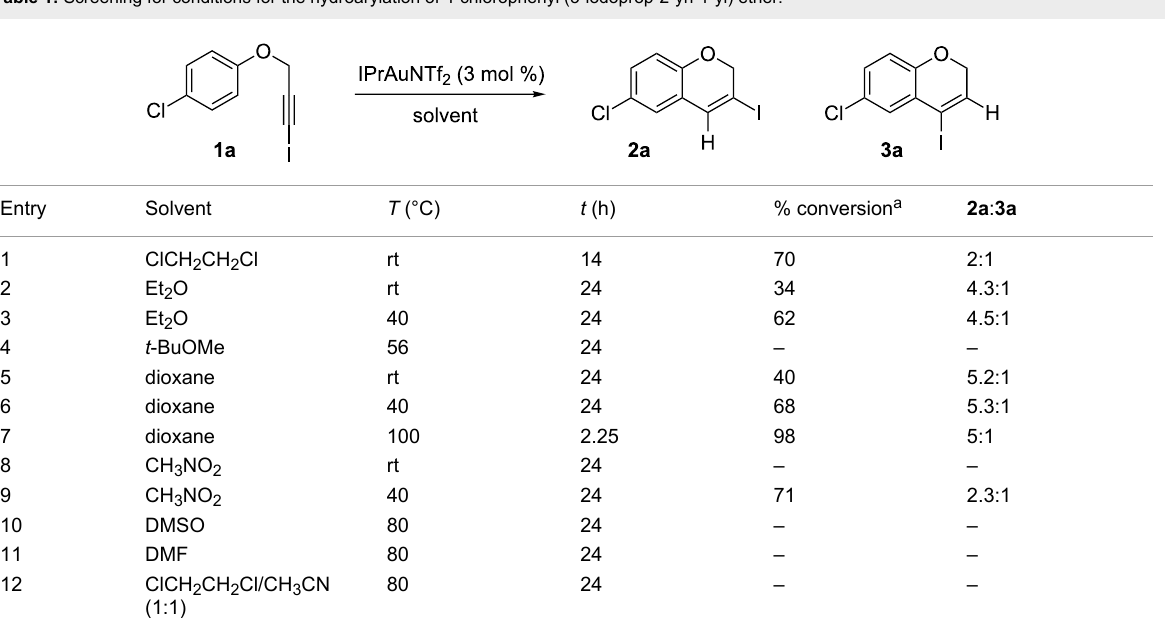
Table 1: Screening for conditions for the hydroarylation of 4-chlorophenyl (3-iodoprop-2-yn-1-yl) ether.